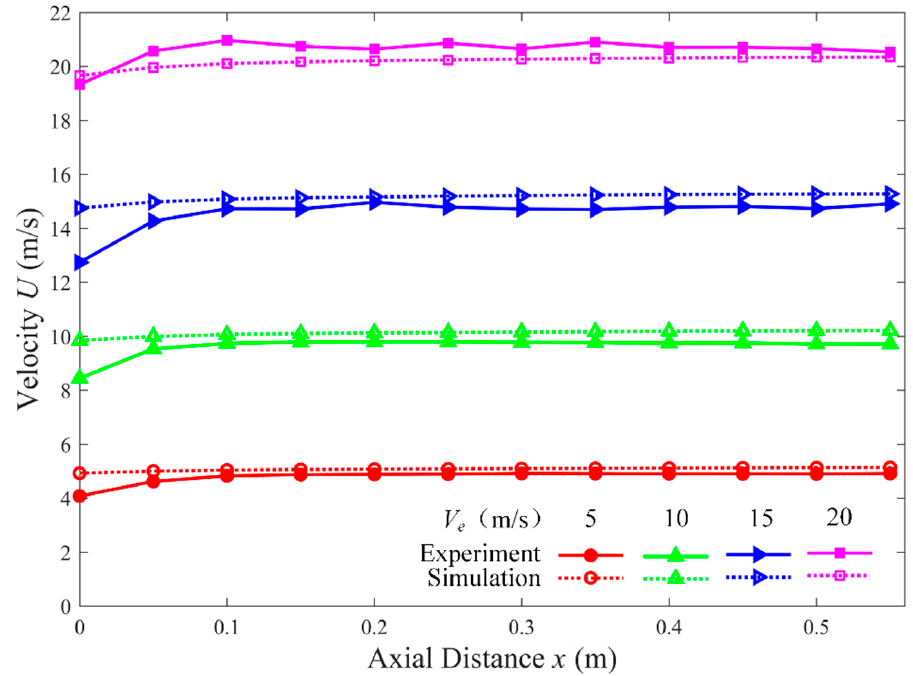
Figure 14. Variation of velocity with axial distance obtained experimentally and numerically.